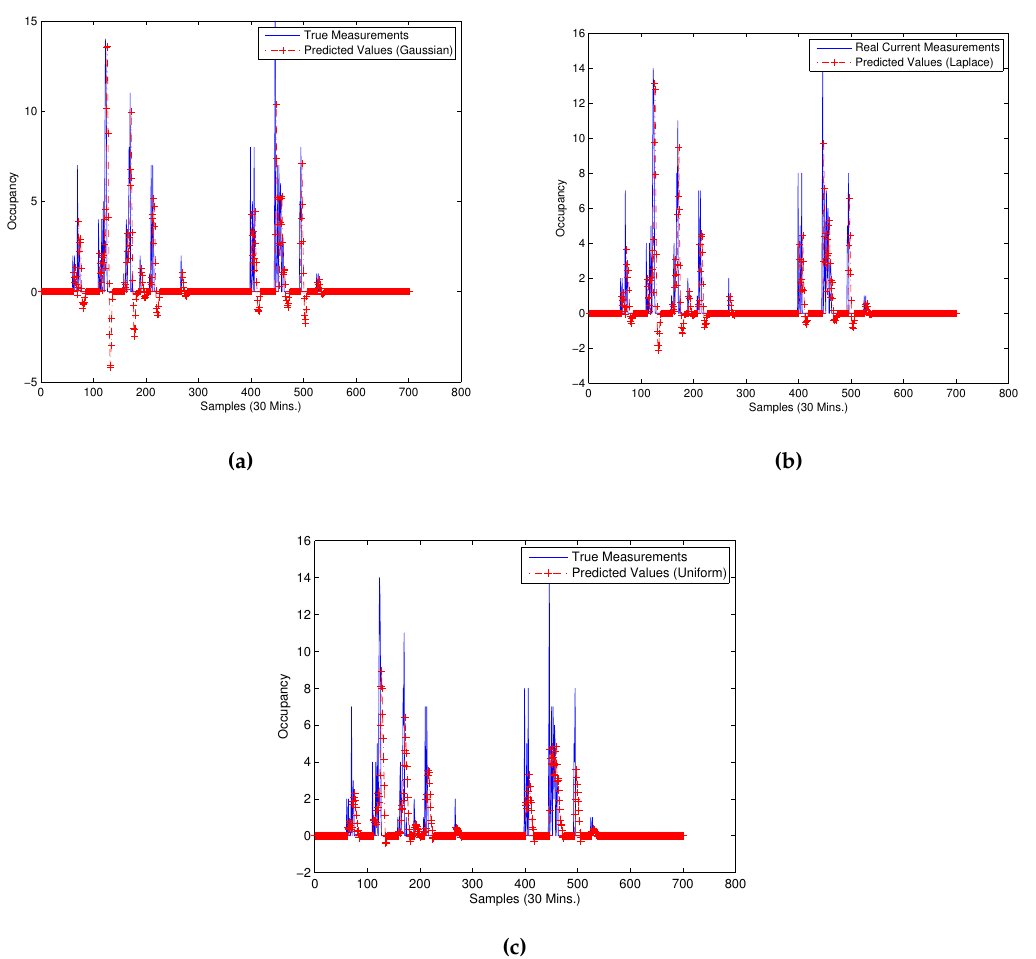
Figure 7. Occupancy estimation using three different basis functions: ( a ) Gaussian basis functions; ( b ) Laplace basis functions; ( c ) Uniform basis